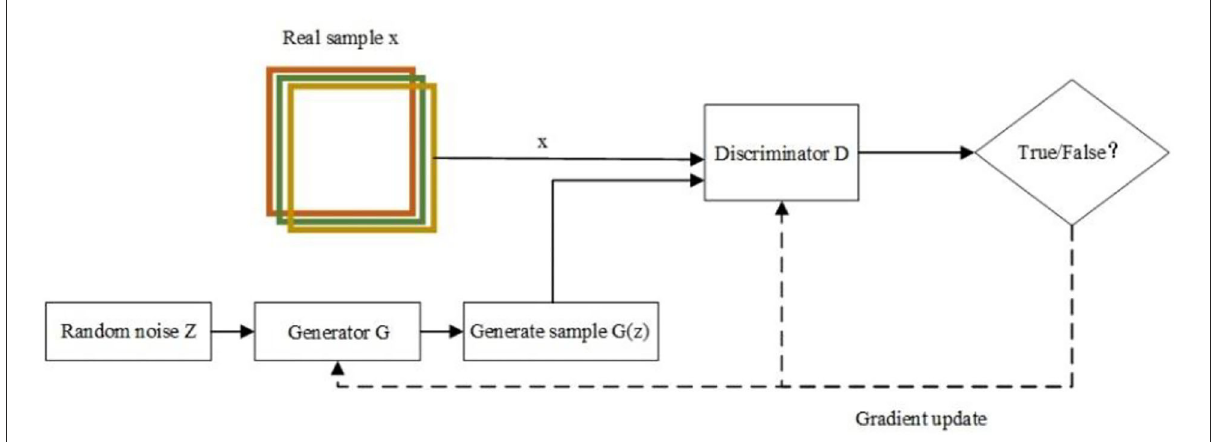
FIGURE1 A schematic diagram of the GAN